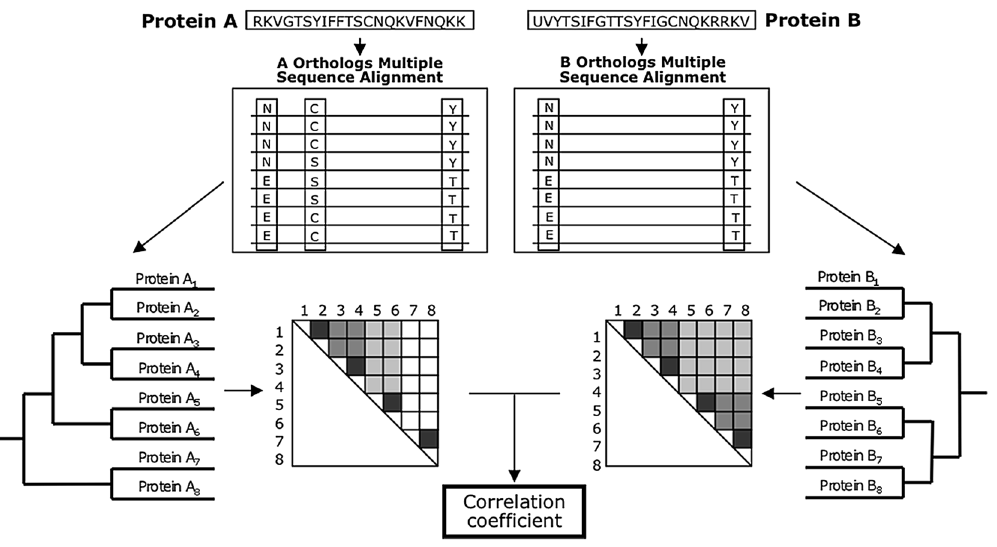
Figure 3. A schema of the mirrortree method for predicting interacting proteins. The orthologs of two proteins (A and B from the same species) are used to construct two multiple sequence alignments (MSAs). Distance matrices, which implicitly represent evolutionary trees, are constructed from the MSAs. Each matrix square represents the tree distance between two orthologs and dark colors represent closeness. The two distance matrices are compared using linear correlation. A high correlation between the distance matrices suggests interaction between proteins A and B.